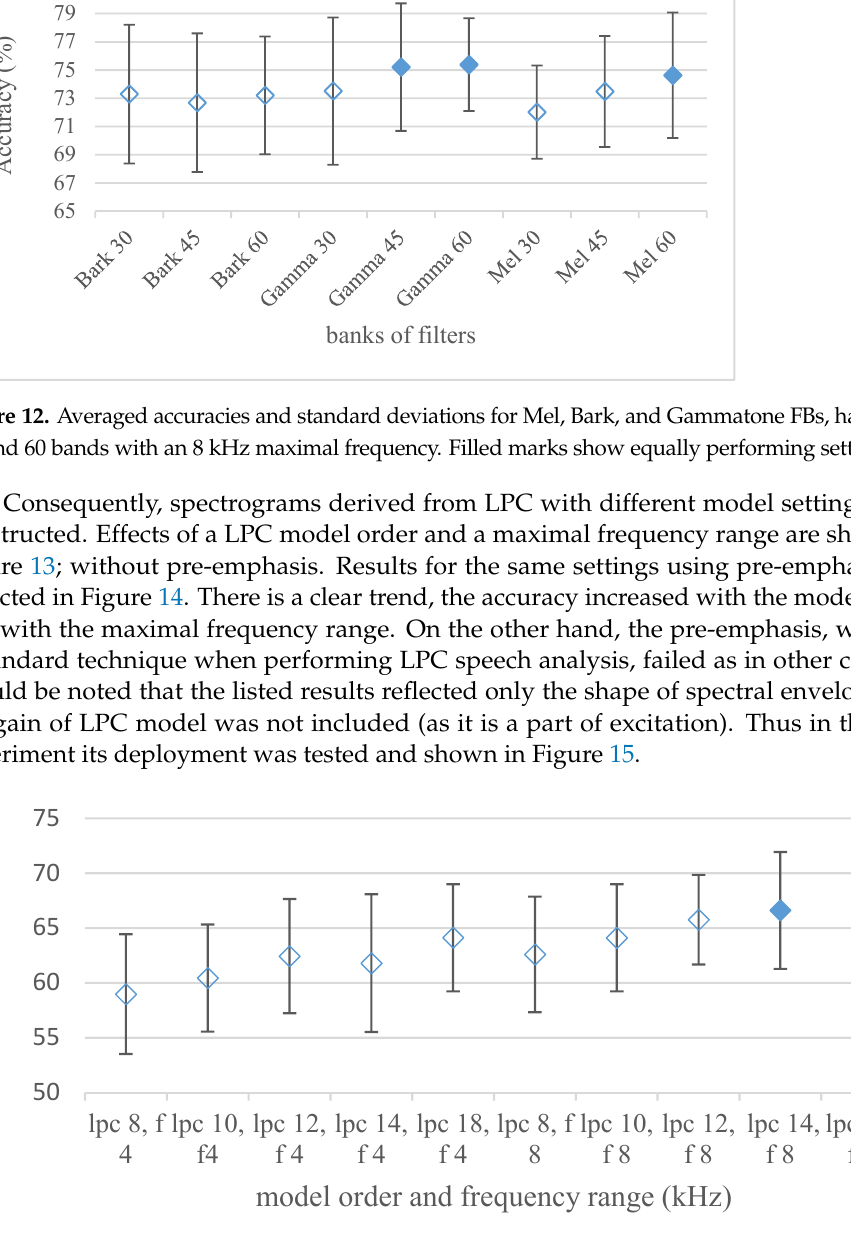
13 of 27 Figure 11. Averaged accuracies and standard deviations for different modifications of spectral magnitudes: magnitude (Mag), power (Pow), log magnitude, and log power, for 4 and 8 kHz max-